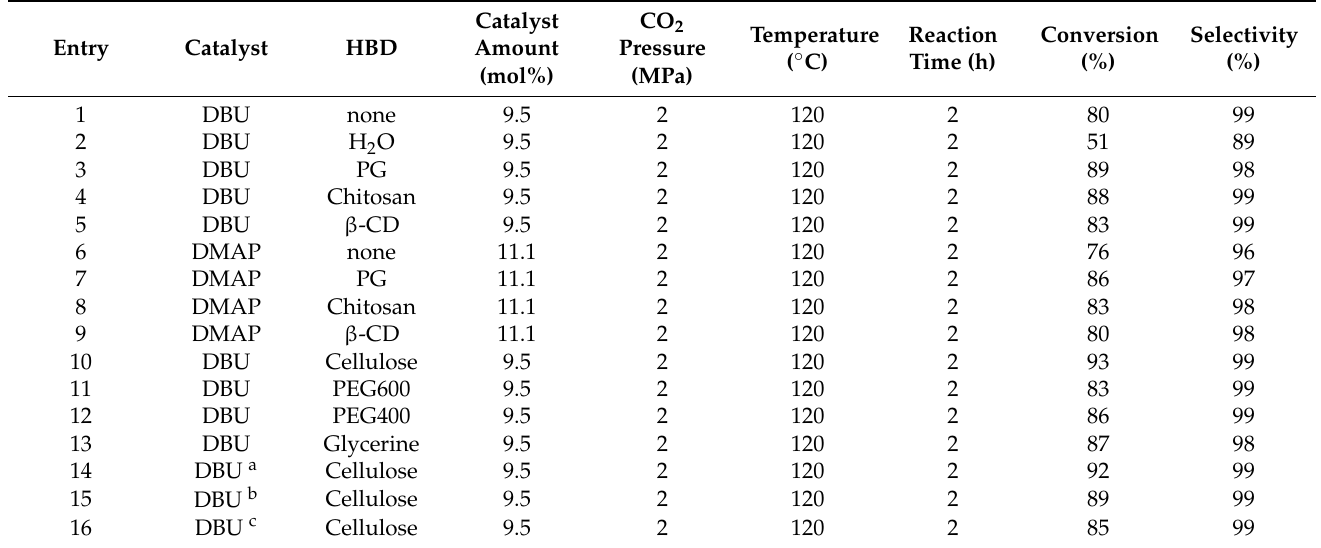
Table 7. Catalyst screening for the base catalyzed cycloaddition reaction of PO; effects of different HBDs